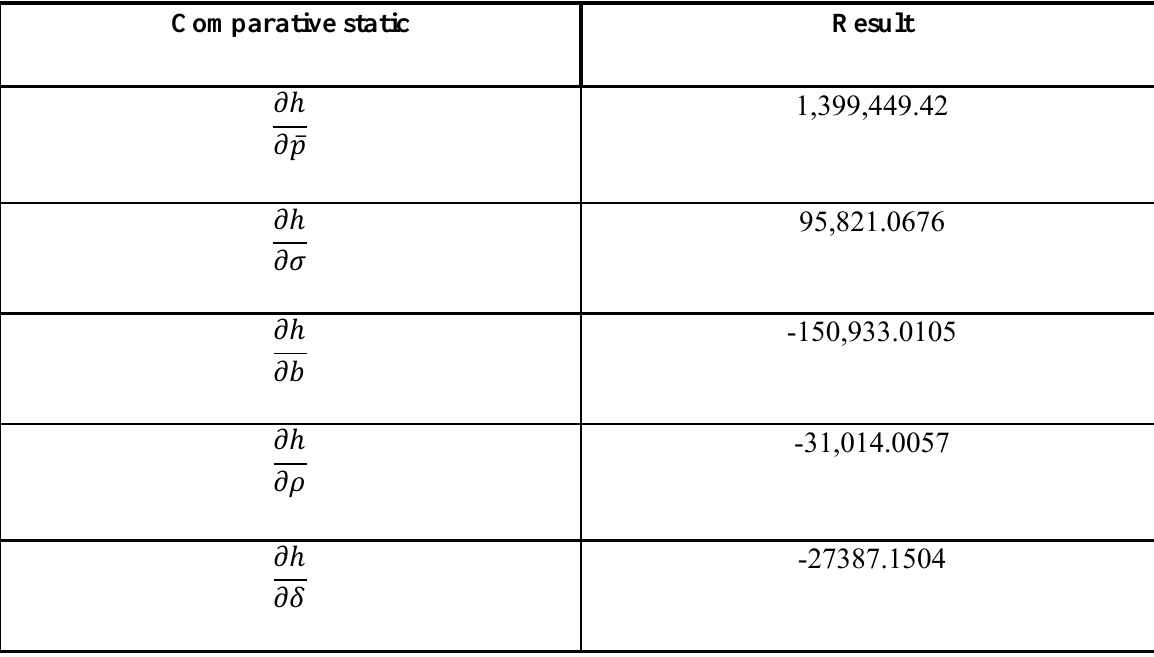
Table 4. Comparative Statics Results for Optimal